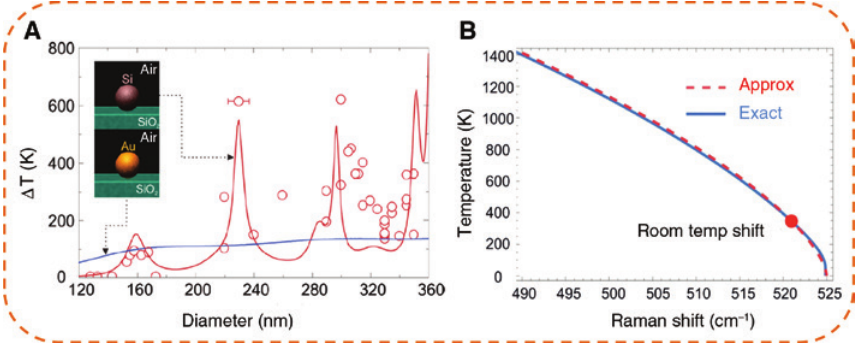
Figure 5: Optically induced heating and thermometry in high-refractive index NPs. (A) Comparison of temperatures achieved in plasmonic and dielectric NPs. The results of theory (solid lines) and experiment (circles) are = 2 mW/ μ m 2 . (B) Results of calculation of the temperature-dependent Raman shift on the represented. Heating conditions, λ = 633 nm, I 0 temperature for Si NP from (13) (solid line) and its approximation (dotted line). Reprinted with permission from [26, 52]. Copyright 2017 American Chemical Society; Copyright 2017 by Wiley-VCH Verlag GmbH & Co. KGaA,